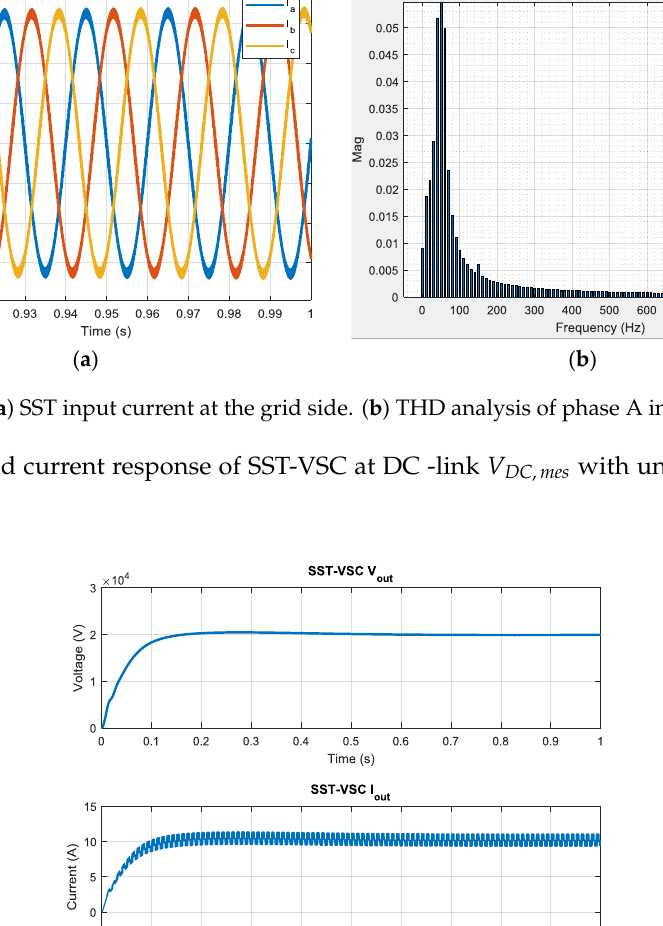
Figure 17. SST-VSC voltage and current at the DC -link.